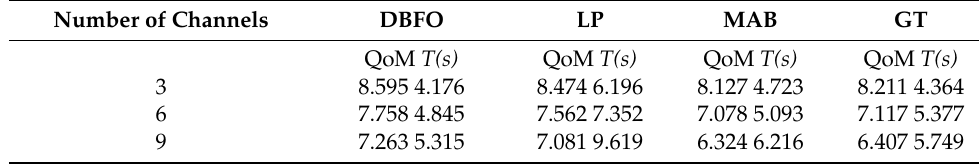
Table 3. Statistical results of four algorithms with different channel numbers.